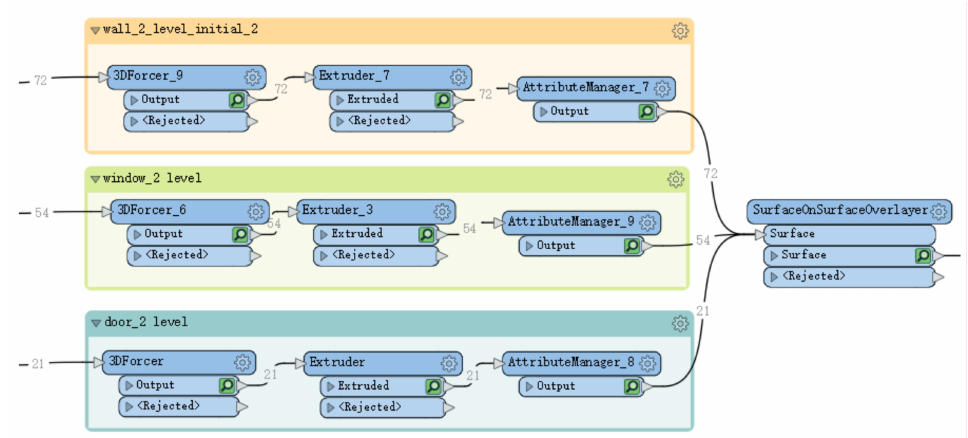
Figure 22. Extraction of Interior walls, doors and windows.